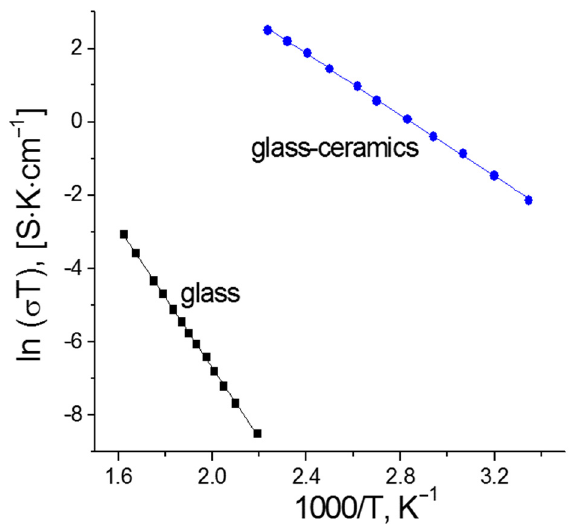
Figure 9. Comparison of total conductivity for Li 1.6 Al 0.5 Ge 1.5 Si 0.1 P 2.9 O 12 glass and glass-ceramics.